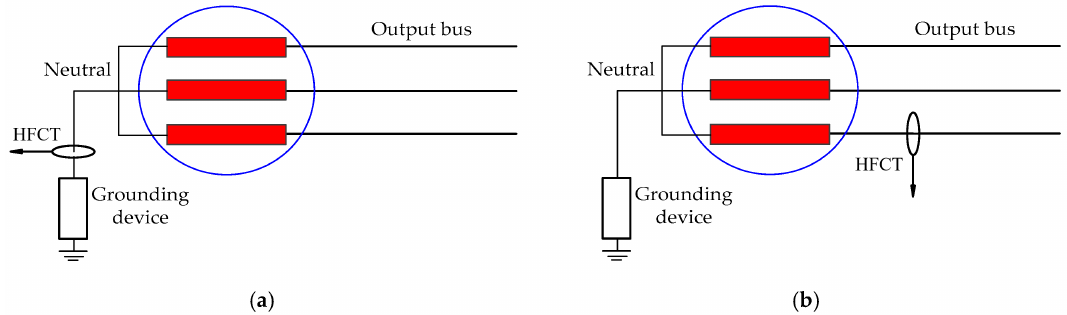
Figure 5. Configurations ( a ) neutral ground connection, ( b ) terminal, adapted from